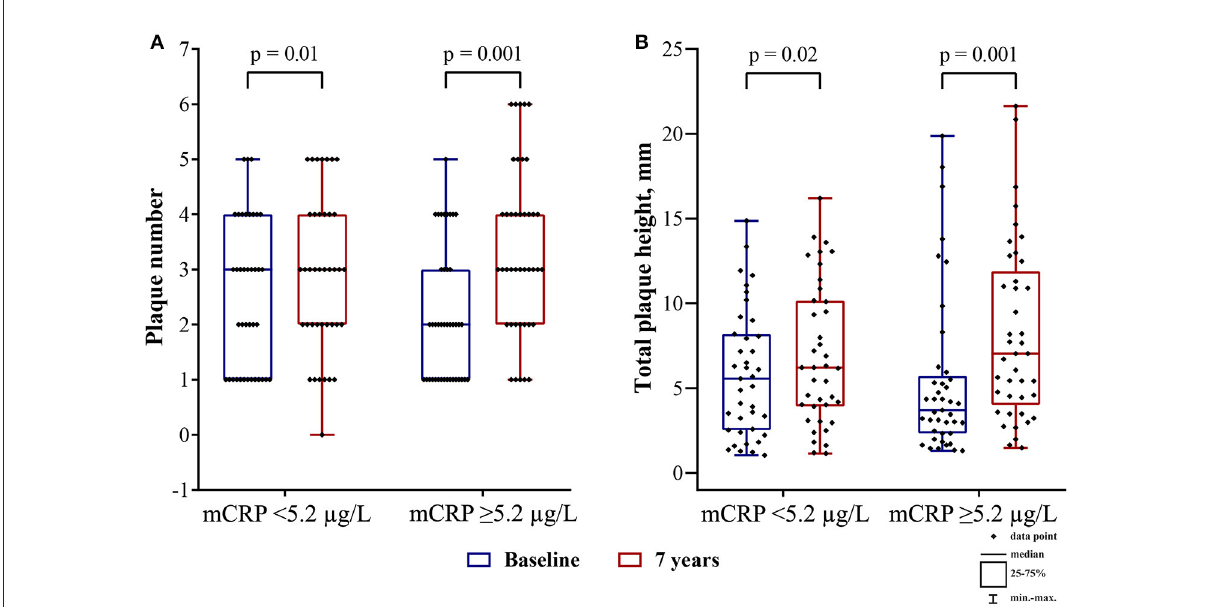
FIGURE4 (A) plaque number and (B) total plaque height at baseline (blue boxplots) and the 7th-year follow-up survey (red boxplots) in the patients with the mCRP level below median or the median mCRP level or higher. At the 7th-year follow-up survey, the intragroup change in all markers was significant (Wilcoxon signed-rank test). mCRP, monomeric C-reactive protein.